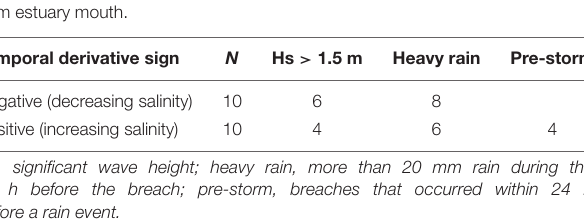
Frontiers in Marine Science |